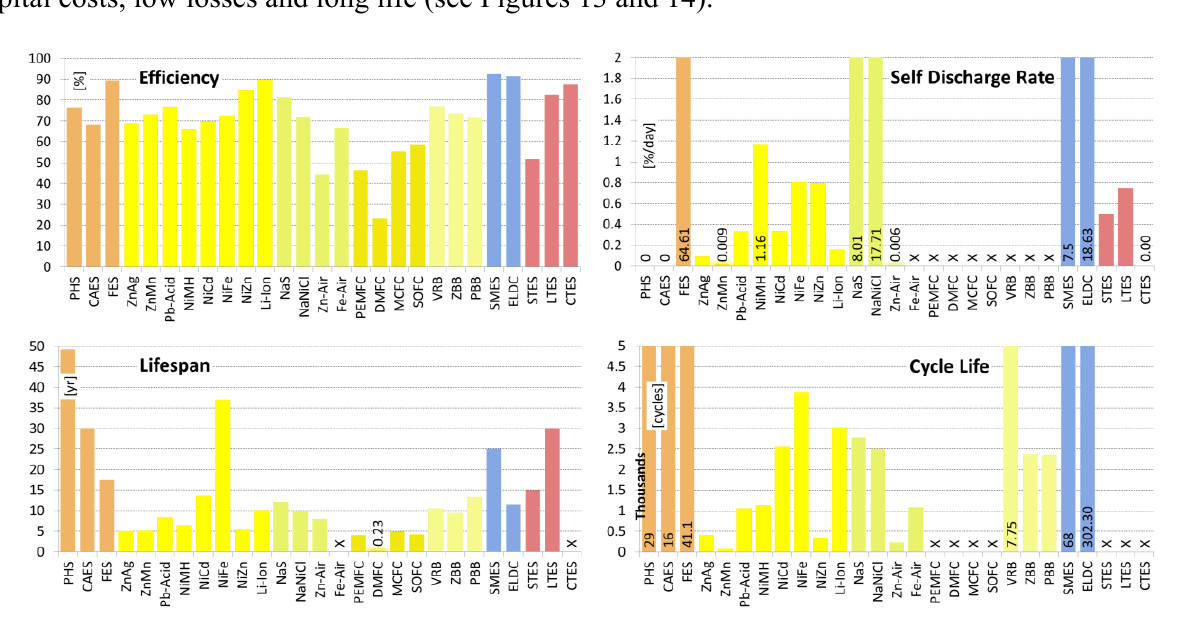
Figure 13. Comparing storage effectiveness across storage devices. Data points marked with “X” are unknown.